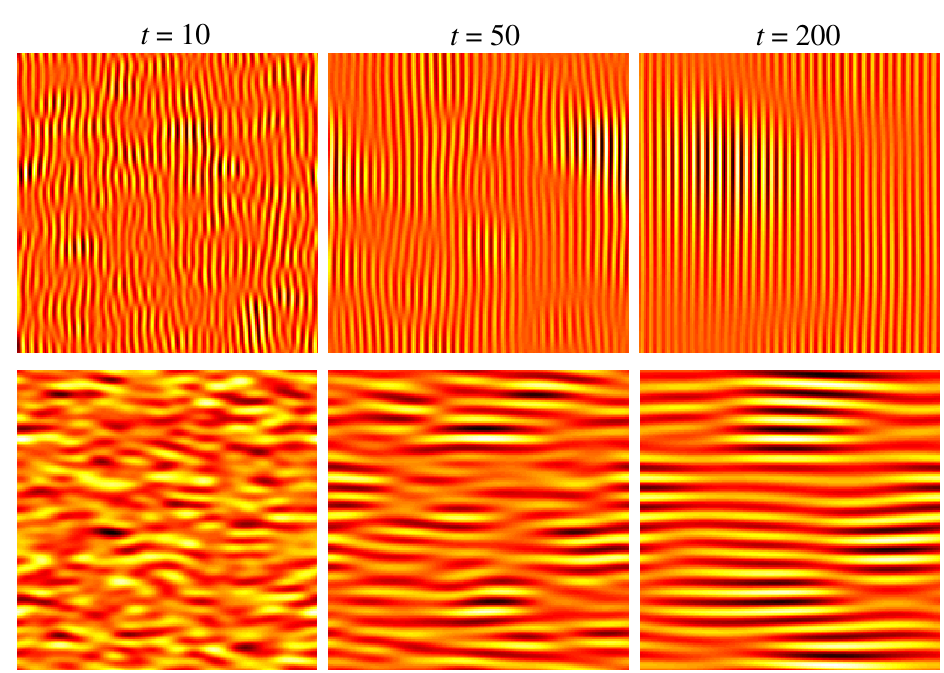
Figure 4. Numerical integration of the BH equation (25) for the same parameters as in Figure 3 at θ = 65 ◦ (upper row) and θ = 75 ◦ (lower row) and different times t . K was set to K = 1 . t =